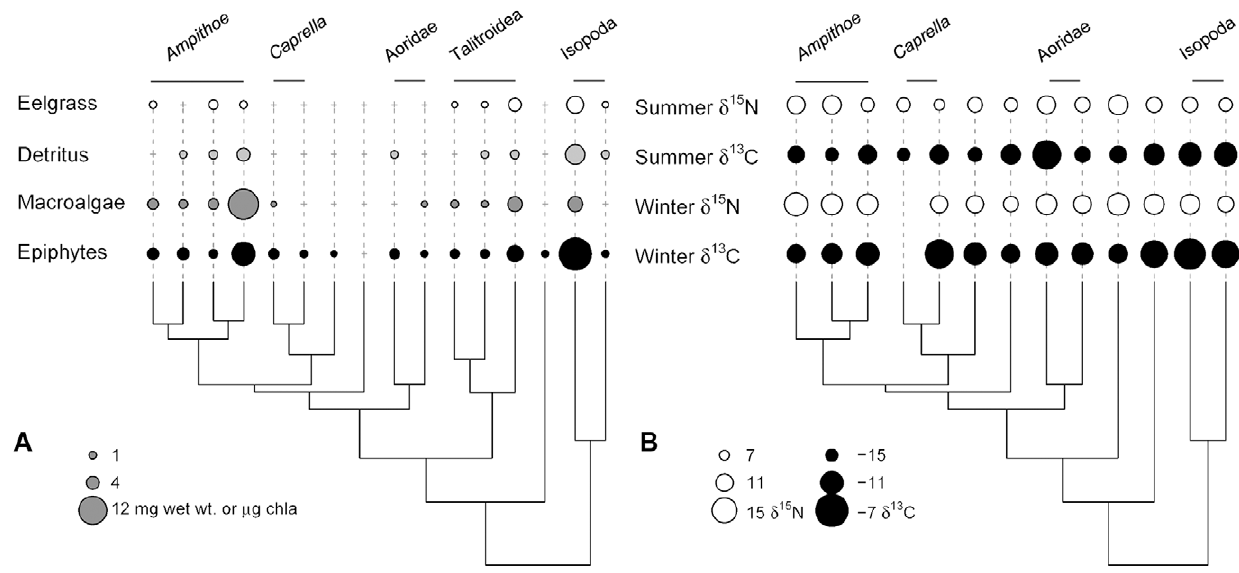
Figure 6. Relationship between phylogeny and A) feeding rates, B) stable isotope signatures. In A) circle size indicates feeding rates (species with non-significant feeding rates on a particular food [compared to controls] have that rate set to 0; this is indicated by a + sign). Feeding rates for eelgrass, detritus, and macroalgae ( Ulva spp.) were measured in mg wet weight consumed per individual per day, so circle size is comparable between those foods. Feeding rates on epiphytes were measured in m g chla per individual per day, and so are not on the same scale as the other 3 foods. In B), larger circles indicate higher d 13 C or d 15 N. The scale is comparable across seasons within a single isotope only (i.e., N or C). Note that the 3 species found on the outer coast have been trimmed from the phylogeny and excluded from the analysis of phylogenetic signal. The species with missing winter values is present only in the summer. Additional figures with both means and standard errors for each trait are available as supplementary material (Figure